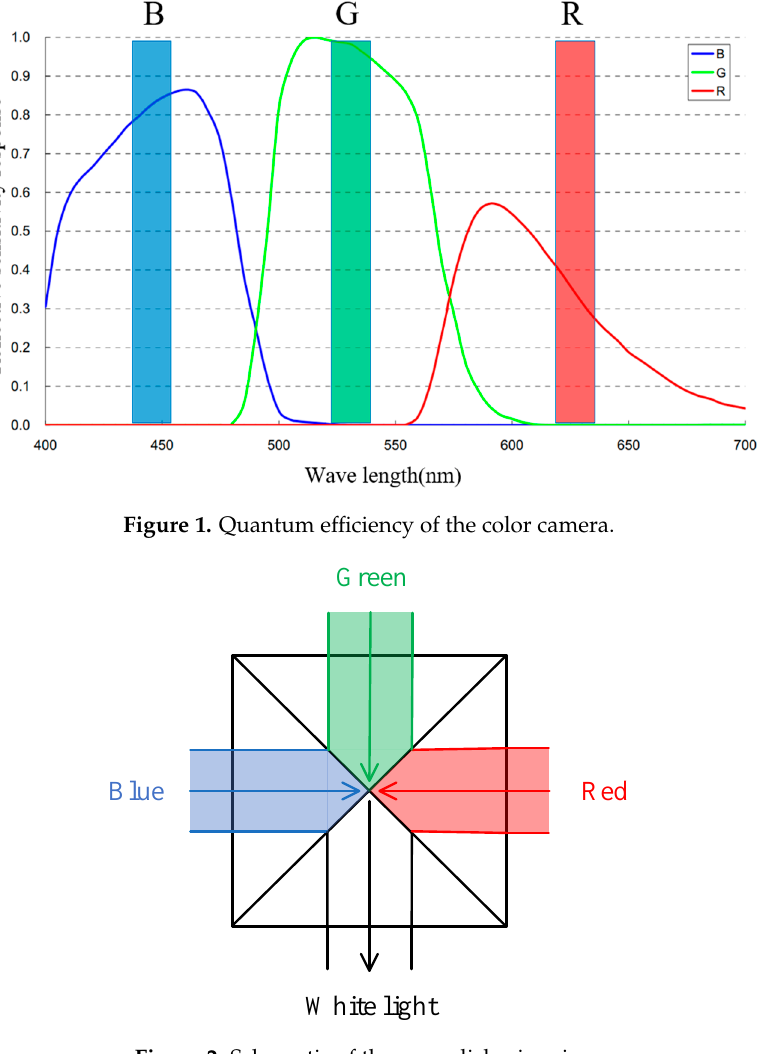
Figure 2. Schematic of the cross dichroic prism.